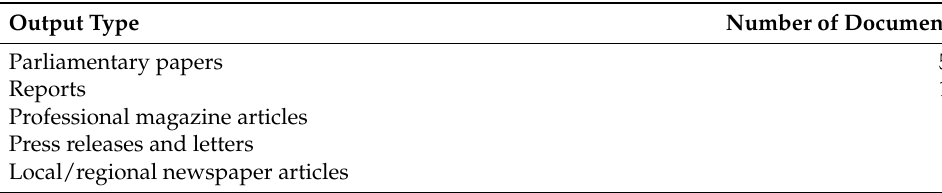
Table 1. Overview of documents used in the